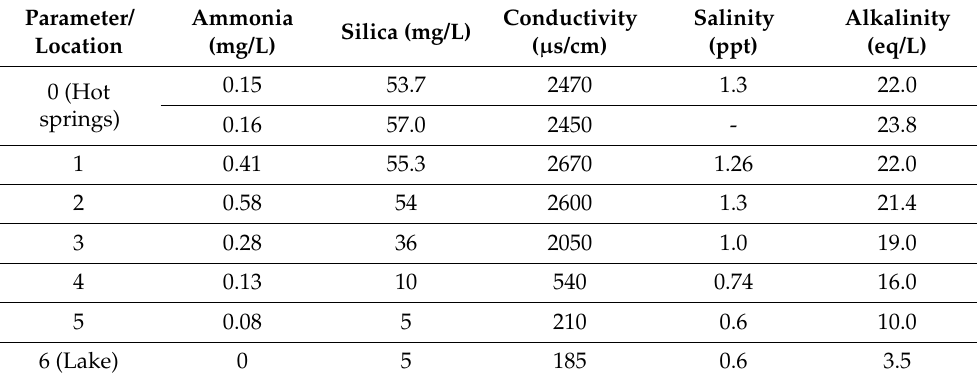
Table 2. The concentrations of chemicals at seven locations taken at the male site.